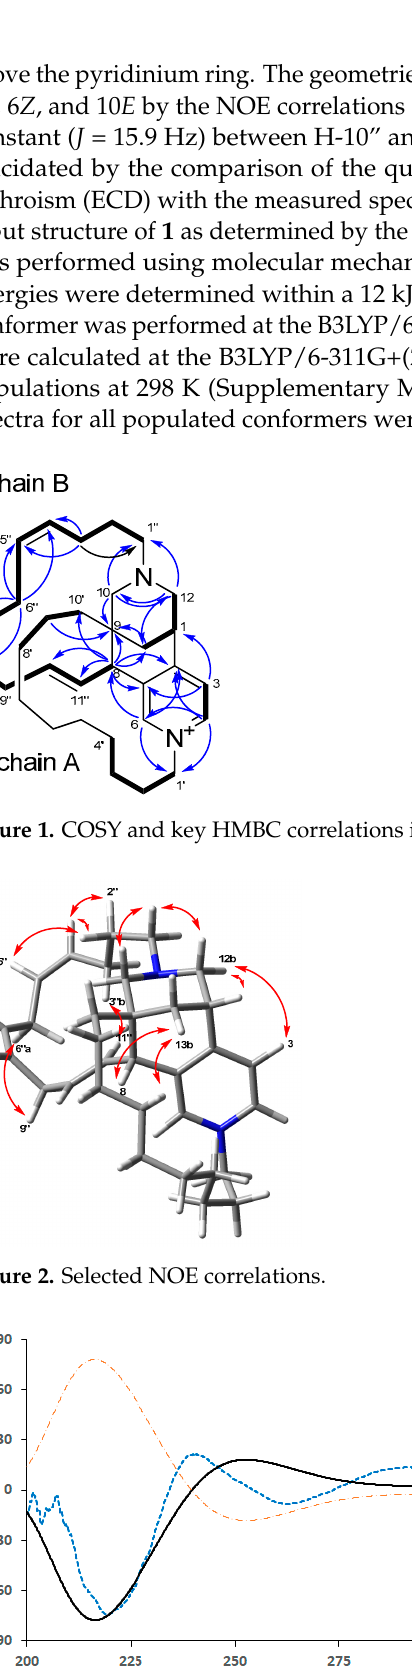
Figure 2. Selected NOE correlations.